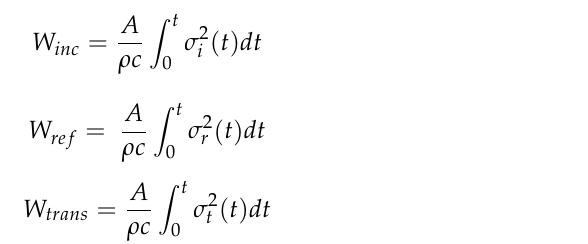
Figure 10. Typical profile of absorbed energy 𝑊